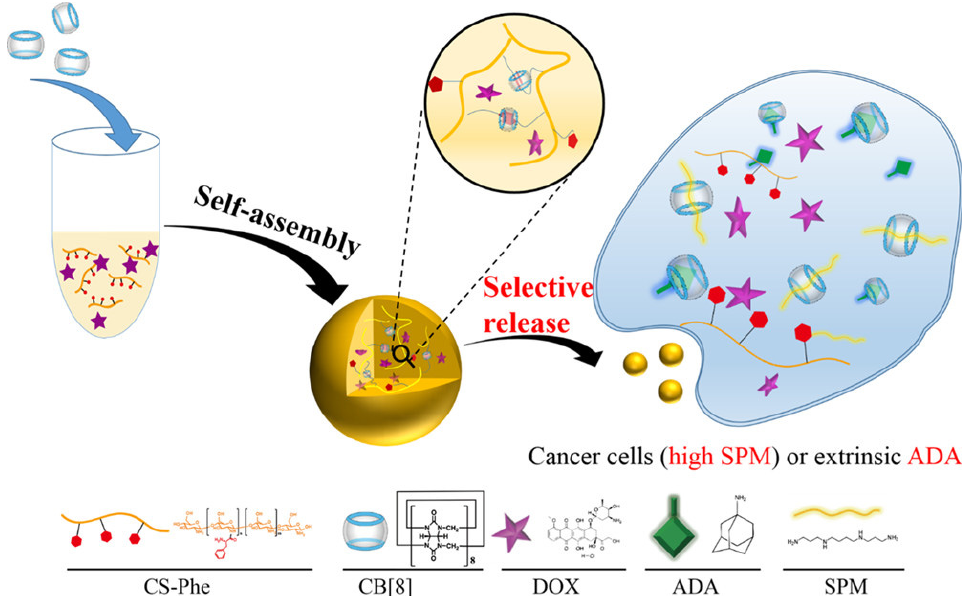
Figure 19. Illustration of preparation of supramolecular CNGs triggered by host–guest interaction and release of stimulated response loads in cancer cells (reproduced with permission of American Chemical Society from ref. [88]).